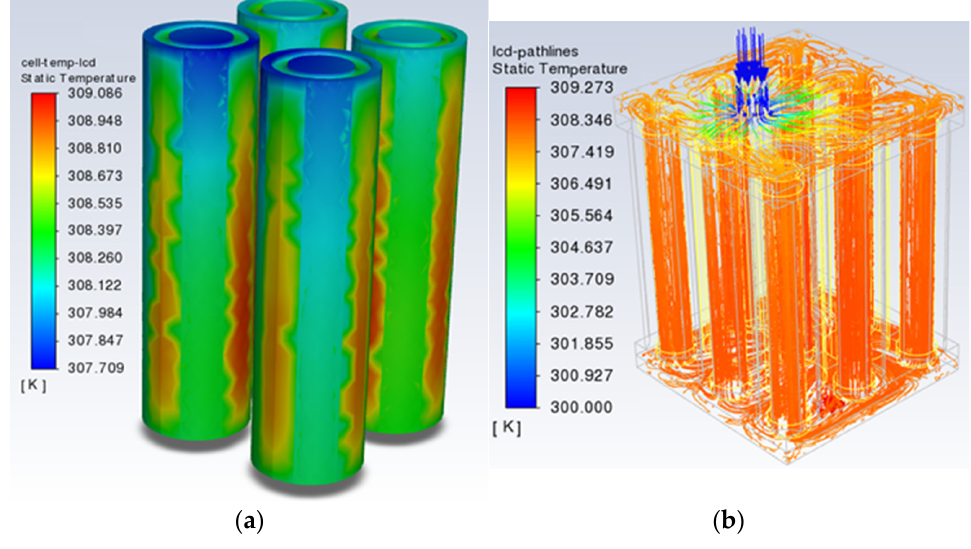
Figure 11. LCD contours: ( a ) Cell temperature (K); ( b ) Fluid pathlines.